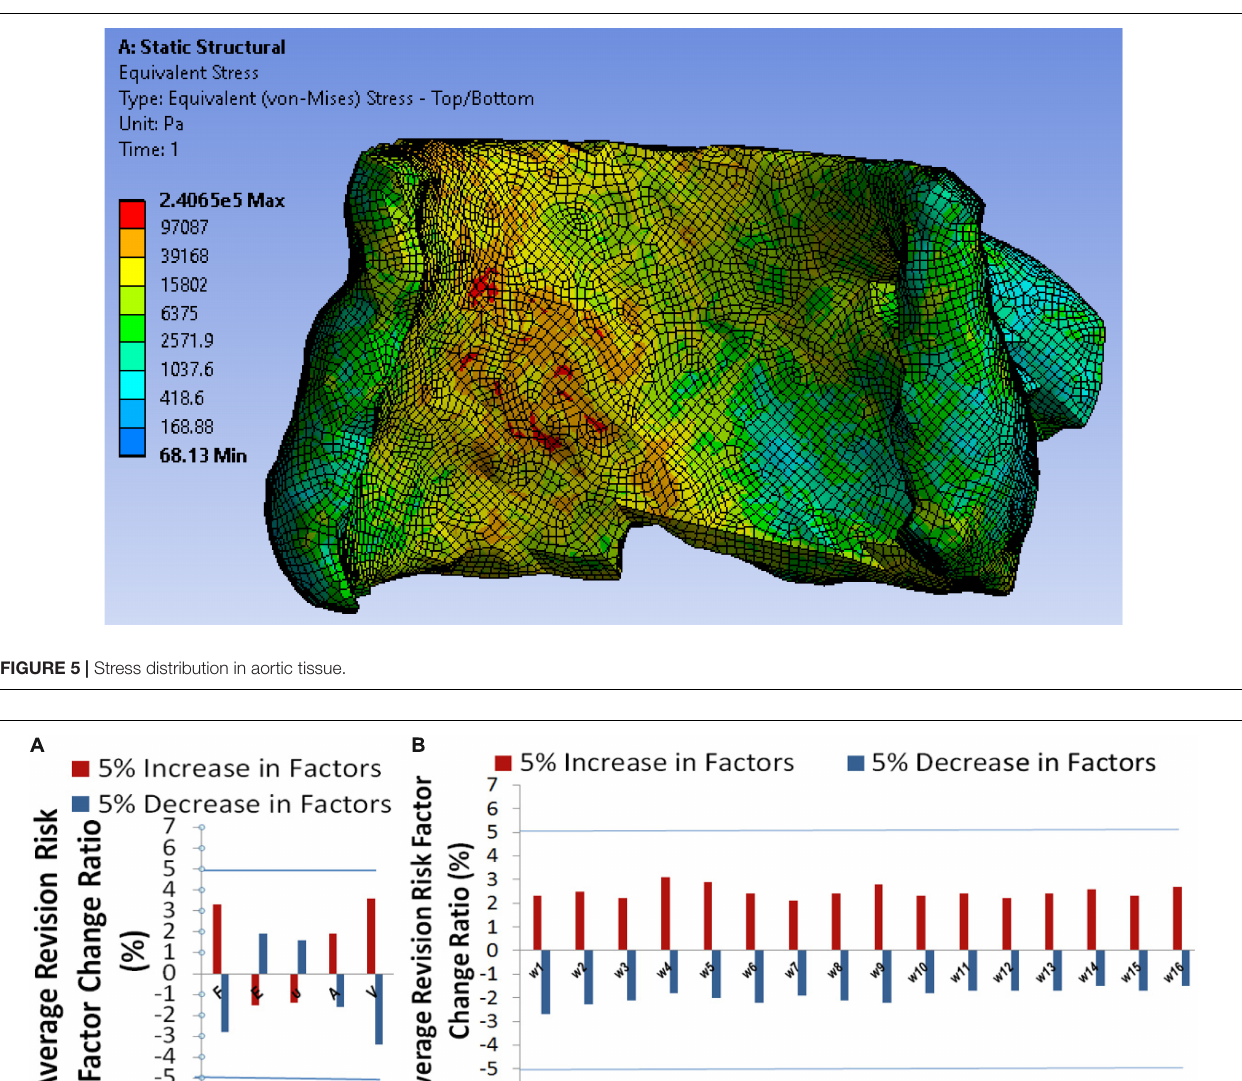
, and w 16 (corresponding to calcified i = 1